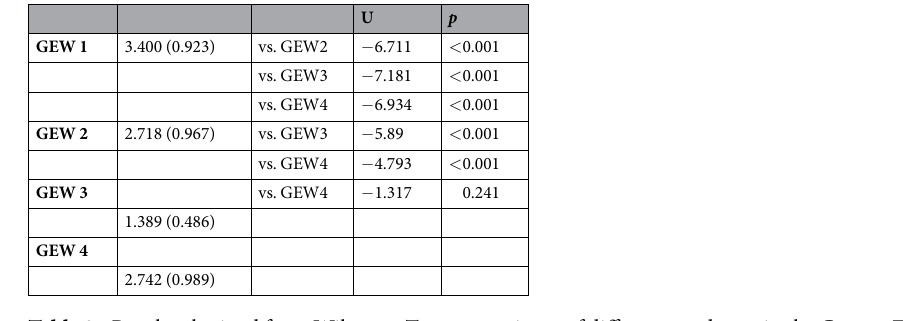
(PwMS vs. HC), revealed a significant difference in the number of emotions with negative valence and high coping potential. In this specific quadrant, in comparison to PwMS group, the HC group reported a significantly higher number of self-reported emotions. No significant differences were observed between groups with respect to the overall number of self-reported felt emotions and their intensities (Table 2). However, findings obtained from the Friedman Test revealed a significant difference among the four quad- rants of GEW in terms of the number of self-reported emotions [ χ 2 (3) = 155.285; p < 0.001]. Wilcoxon tests (with Bonferroni adjustment) indicated that all participants experienced a higher number of emotions with positive valence and high coping potential (Table 3). Assessment using the Flow Short Scale (FSS) revealed that the PwMS group perceived a higher level of chal- lenges when confronted with the proposed activity in comparison to HC. However, no significant between-group difference emerged with respect to the perceived level of skills and challenge-skills balance (Table 2). Both groups endorsed a high appreciation for the activity (Intrinsic Motivation Inventory - IMI) and an intense sense of presence (Slater-Usoh-Steed - SUS - Questionnaire) (Table 2). Classification of PwMS or HC. Tables 4 and 5 show the classification results for discriminating between the HC and the PwMS groups. Naïve Bayes and Support Vector Machine algorithms emerged as the best algorithms for classifying HC and PwMS in their respective groups. Using the scores from conventional executive functions tests as input, the machine learning algorithms showed a classification accuracy between 52.9% and 65.7%. In contrast, the indices from PIT 360° achieved a higher classification accuracy, ranging from 65.7% to 72.9%.